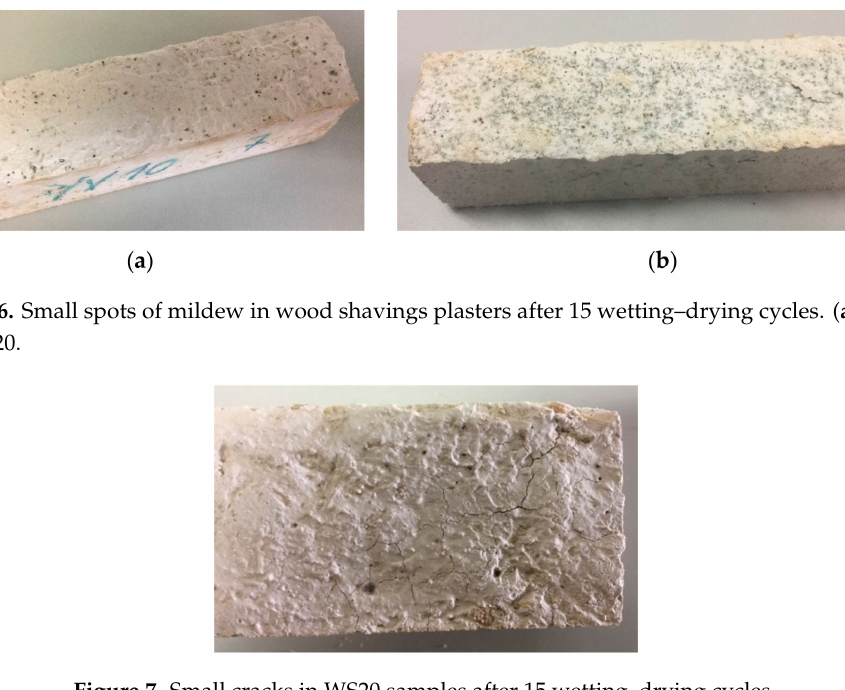
Figure 7. Small cracks in WS20 samples after 15 wetting–drying